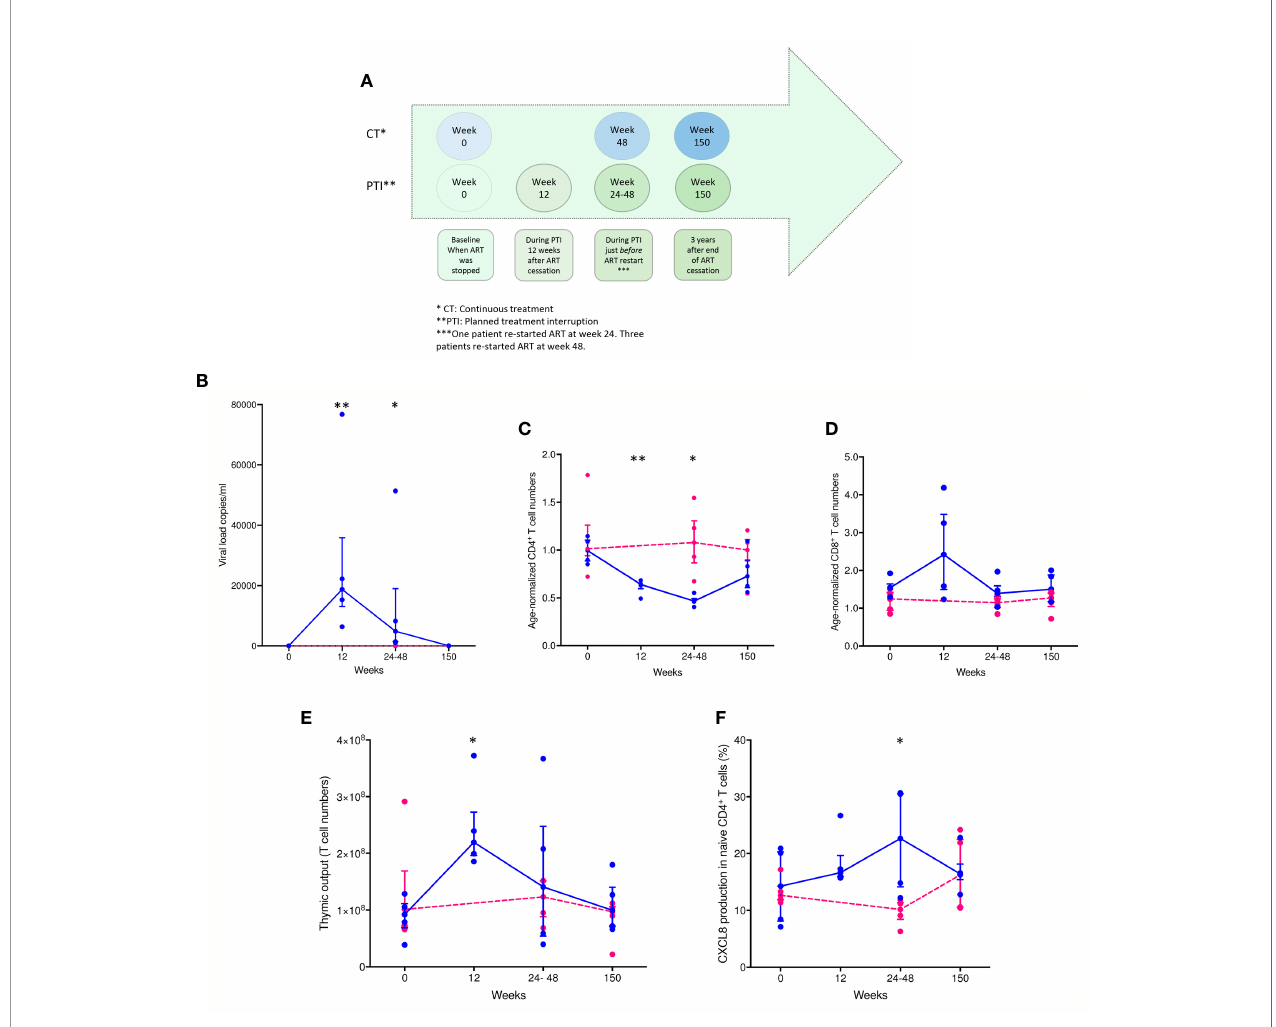
FIGURE 1 | Changes in viral load, age-normalized CD4 + and CD8 + T cell numbers, thymic output and CXCL8 T cell production over time in children with HIV. (A) Timeline of collected patient samples. (B) Viral load (copies per ml). (C) Age-normalized CD4 + T cell counts. (D) Age-normalized CD8 + T cell counts. (E) Thymic output (number of recent thymic emigrants measured by the mathematical model). (F) CXCL8-production in naïve CD4 + , CD45RA + , CD31 + T cells (%). CT children [pink individual measures and dotted lines connecting median(IQR)] and PTI children [blue individual measures and solid lines connecting median(IQR)]. *P ≤ 0.05, **P ≤